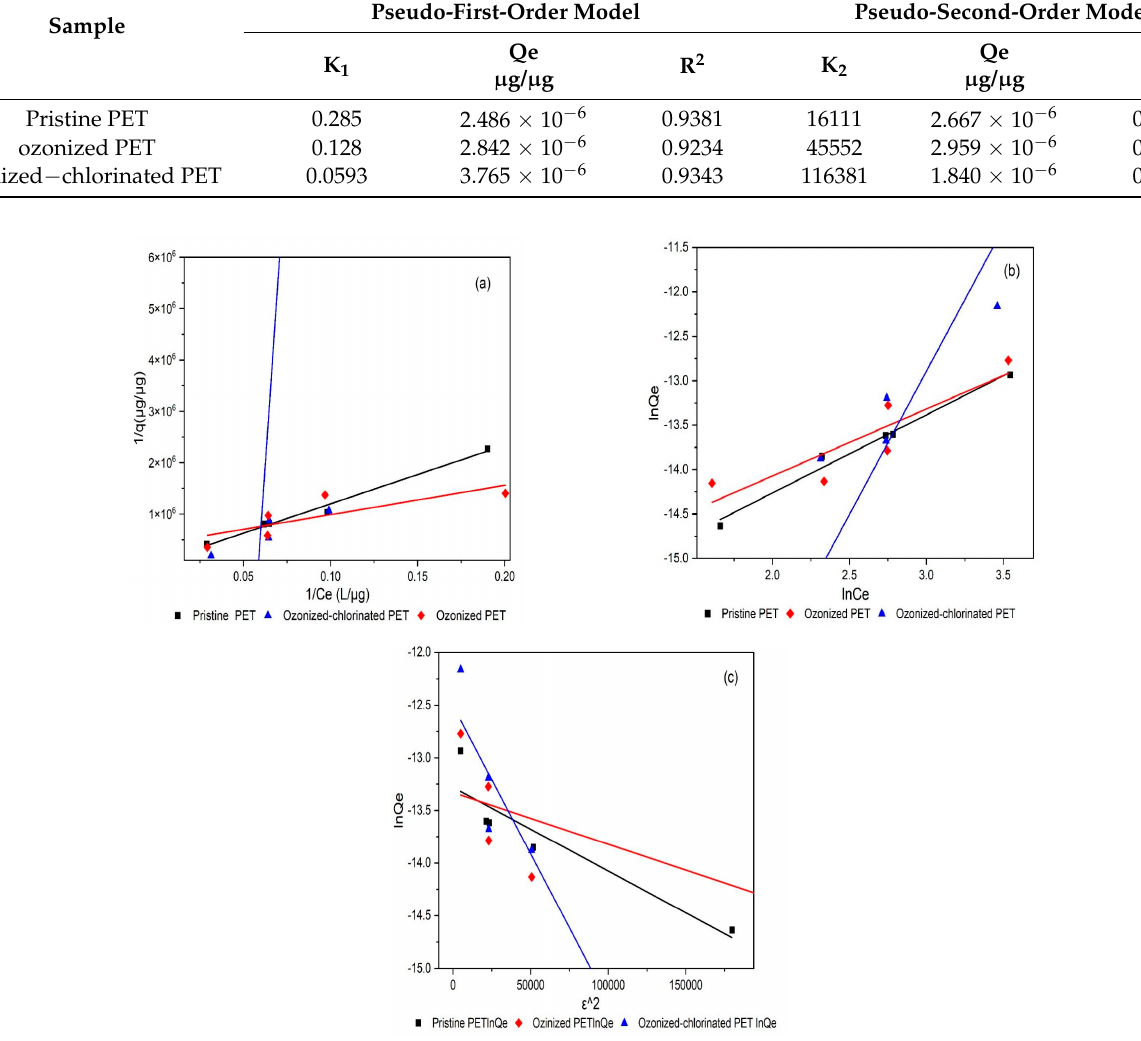
Figure 8. Sorption isotherms of TBM on pristine PET, ozonized PET, and ozonized − chlorinated PET: ( a ) Langmuir model, ( b ) Freundlich model, ( c ) D − R model. Table 3. List of TBM sorption isotherm